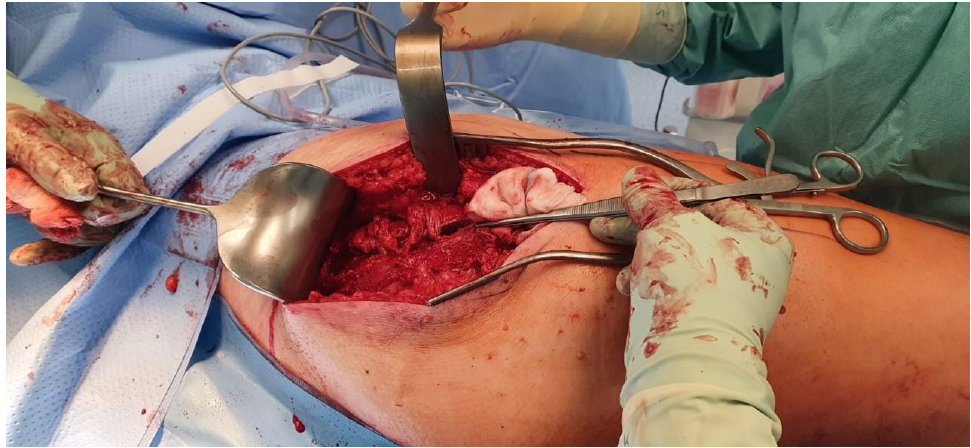
Figure 4. Torn fibers of the gluteus maximus muscle at the insertion to the iliotibial band pointed with the thumb forceps.